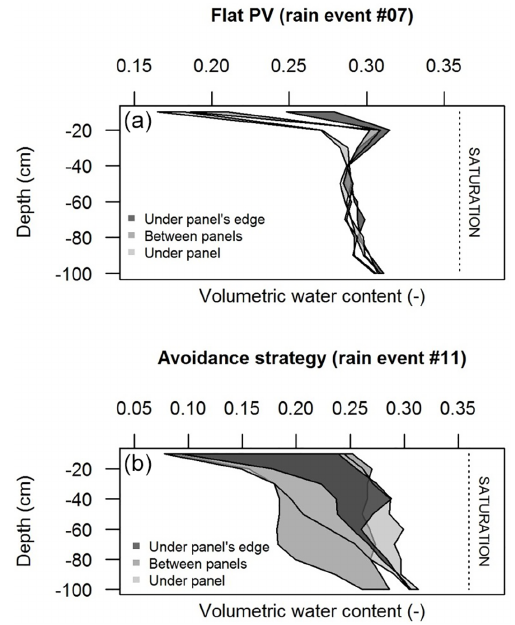
Figure 11. Variations of soil water storage in soil regions located near the aplomb of the panel’s edge (dark grey), between panels (medium grey) and under panels (light grey) for different strategies for operating the panels, holding panels flat during rain event #07 (a) or operating them according to the avoidance strategy that mini- mizes rain interception during rain event #11 (b) . For each case, the leftmost and rightmost line indicate the water content profile before and after the event, respectively. Event #11 was considered as the sum of two successive events for a total rainfall of 60mm in the control zone.